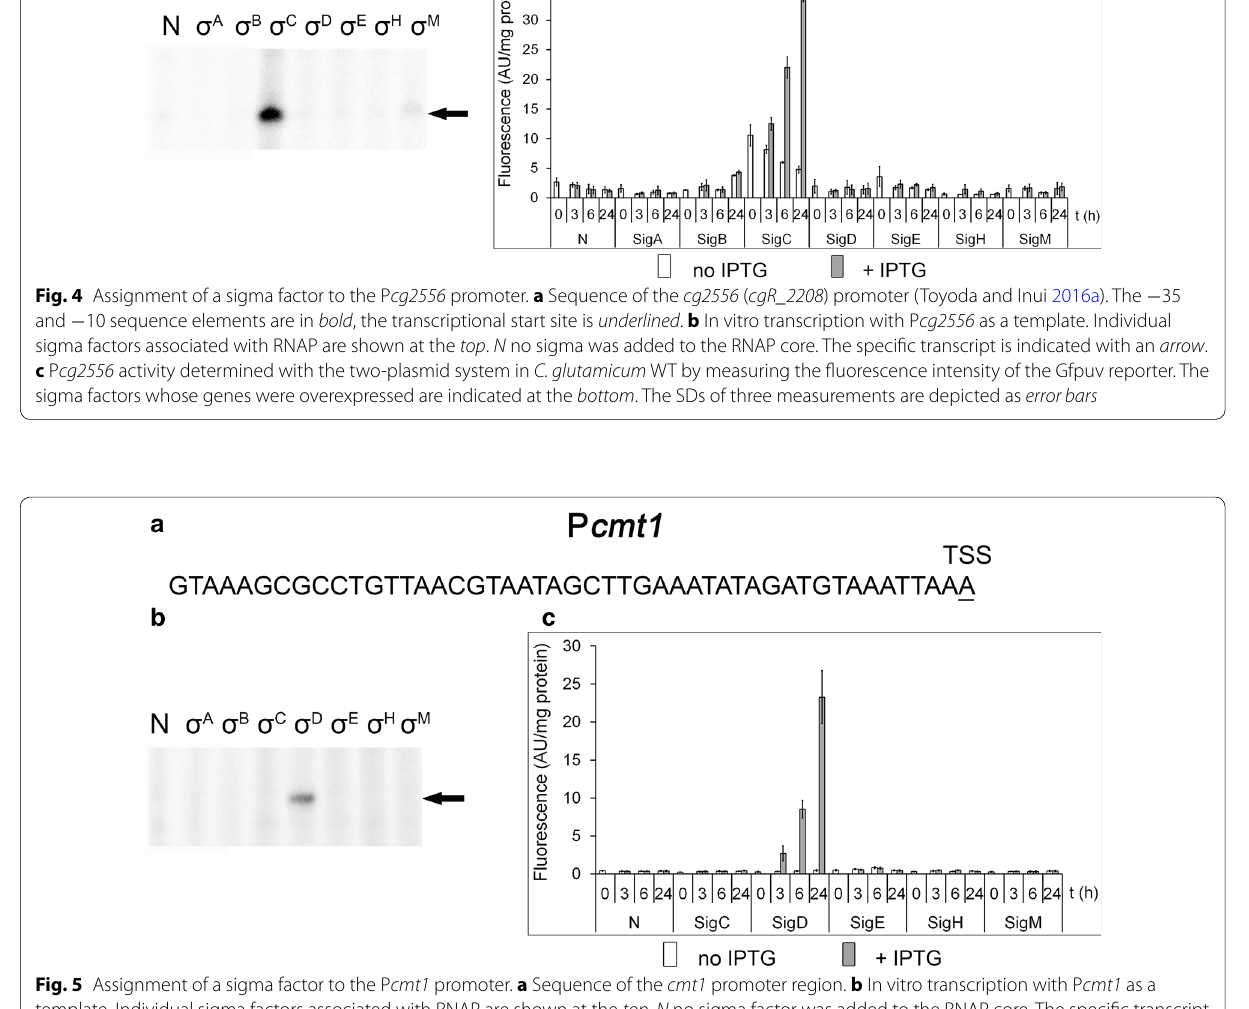
Fig. 5 Assignment of a sigma factor to the P cmt1 promoter. a Sequence of the cmt1 promoter region. b In vitro transcription with P cmt1 as a template. Individual sigma factors associated with RNAP are shown at the top . N no sigma factor was added to the RNAP core. The specific transcript is indicated with an arrow . c P cmt1 promoter activity determined with the two-plasmid system in C. glutamicum WT by measuring the fluorescence intensity of the Gfpuv reporter. The sigma factors whose genes were overexpressed are indicated at the bottom . IPTG was added at time 0. AU arbi- trary units. The SDs of three measurements are depicted as error